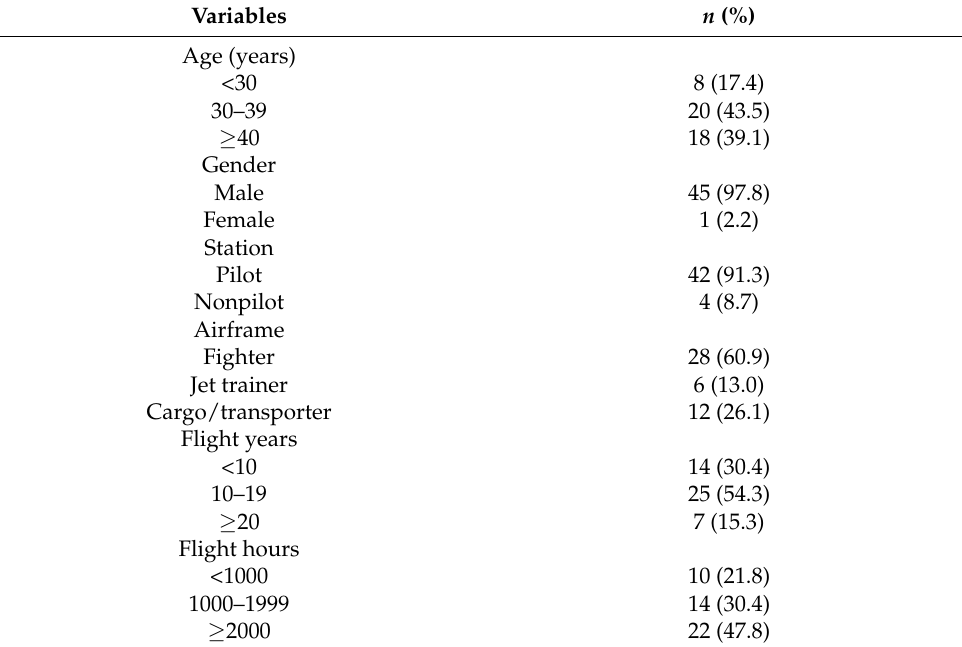
Table 1. Characteristics of study